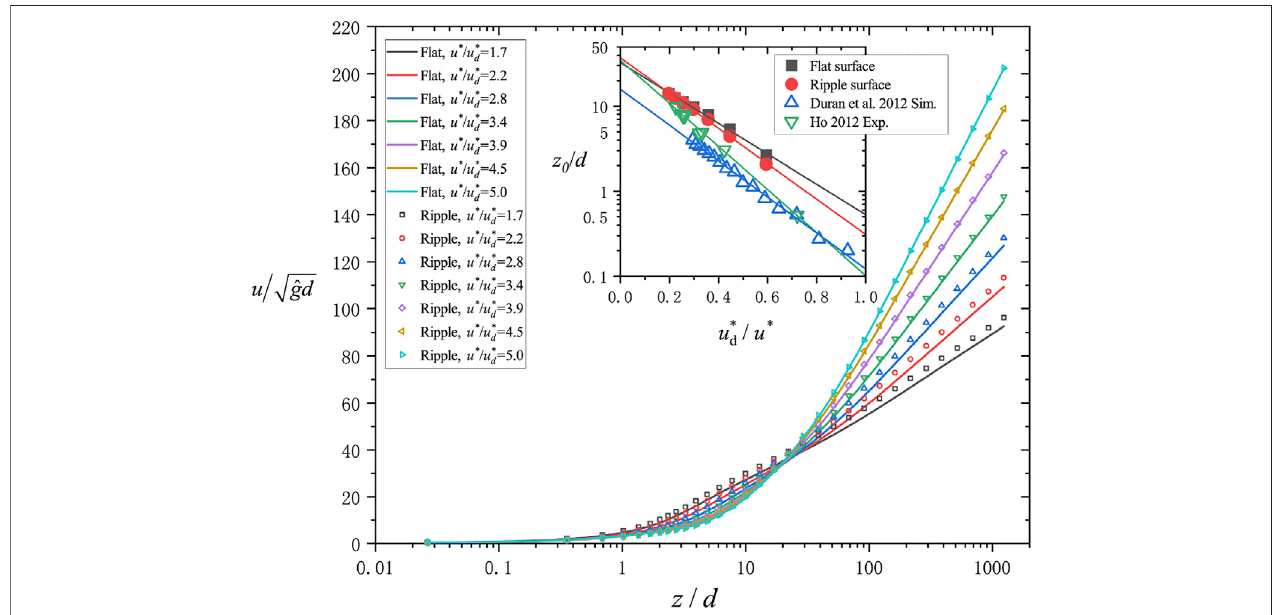
FIGURE 14 | Wind pro fi les corresponding to saturated aeolian sand transport cases. The solid lines represent results on the fl at surface. The scatter symbols are resultsfromcaseswiththeripplesurface.Theinsetdemonstratestherelationshipbetween z 0 and u * .Thehollowsymbolsintheinsetrepresentresultsfromothers ’ work.